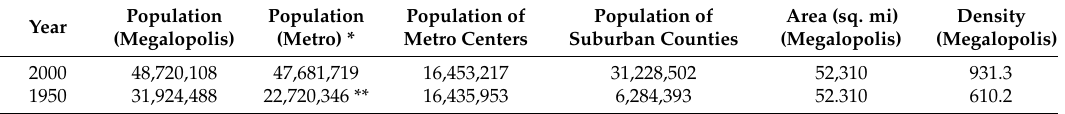
Table 2. Growth of Megalopolis 1950–2000 (after Vicino, Hanlon and Short,